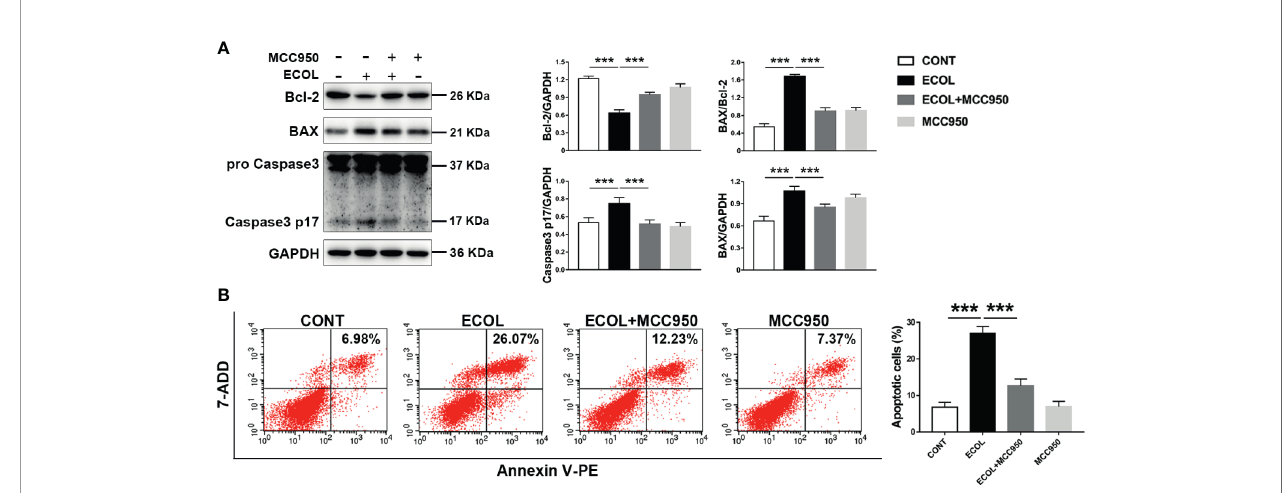
FIGURE 7 | Inhibition of NLRP3 in fl ammasome activation reduces Escherichia coli- induced apoptosis in MAC-T cells. (A) Western blot analysis of BAX, Bcl-2, and Caspase-3. The right panel shows the protein quanti fi cation using ImageJ software (version 1.50). (B) Flow cytometry analysis of the percentage of apoptotic cells. MAC-T cells were pretreated with MCC950 (100 nM) for 0.5 h and then exposed to E coli (MOI = 66) for 8 (h) Data presented are mean ± SEM; n = 3. *** p <